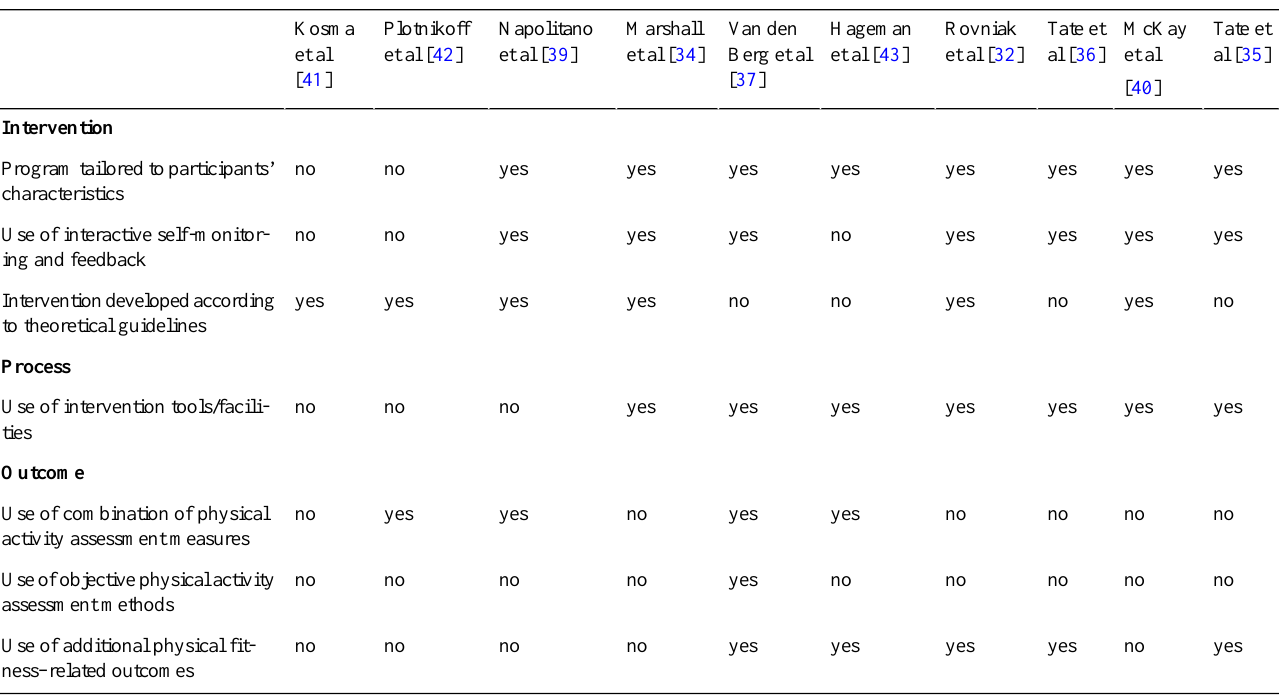
Table 2. Characteristics of intervention, process, and outcome measures of the studies